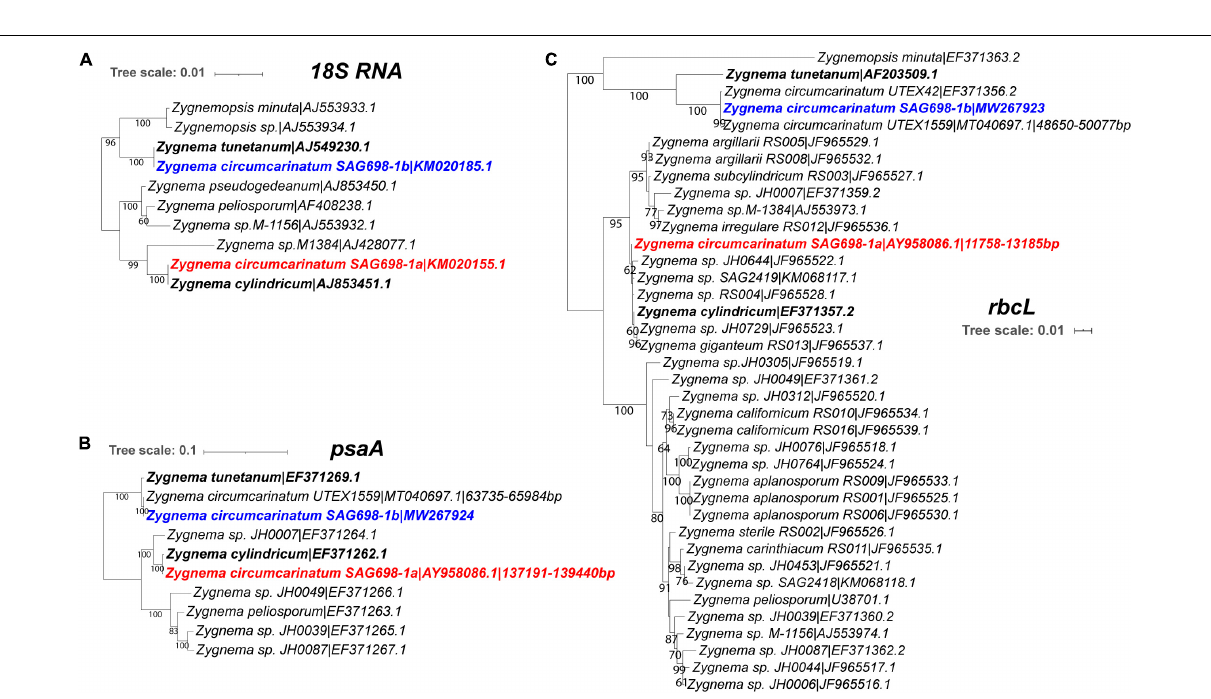
Frontiers in Plant Science |